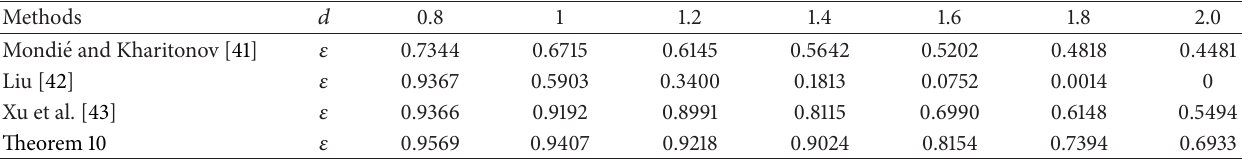
Table 3: Maximum upper bound of 𝜀 with different parameter 𝑑 .